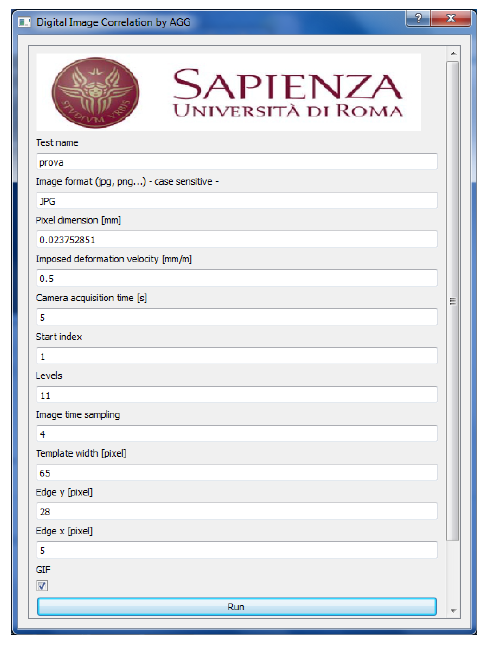
Figure 2: The graphical user